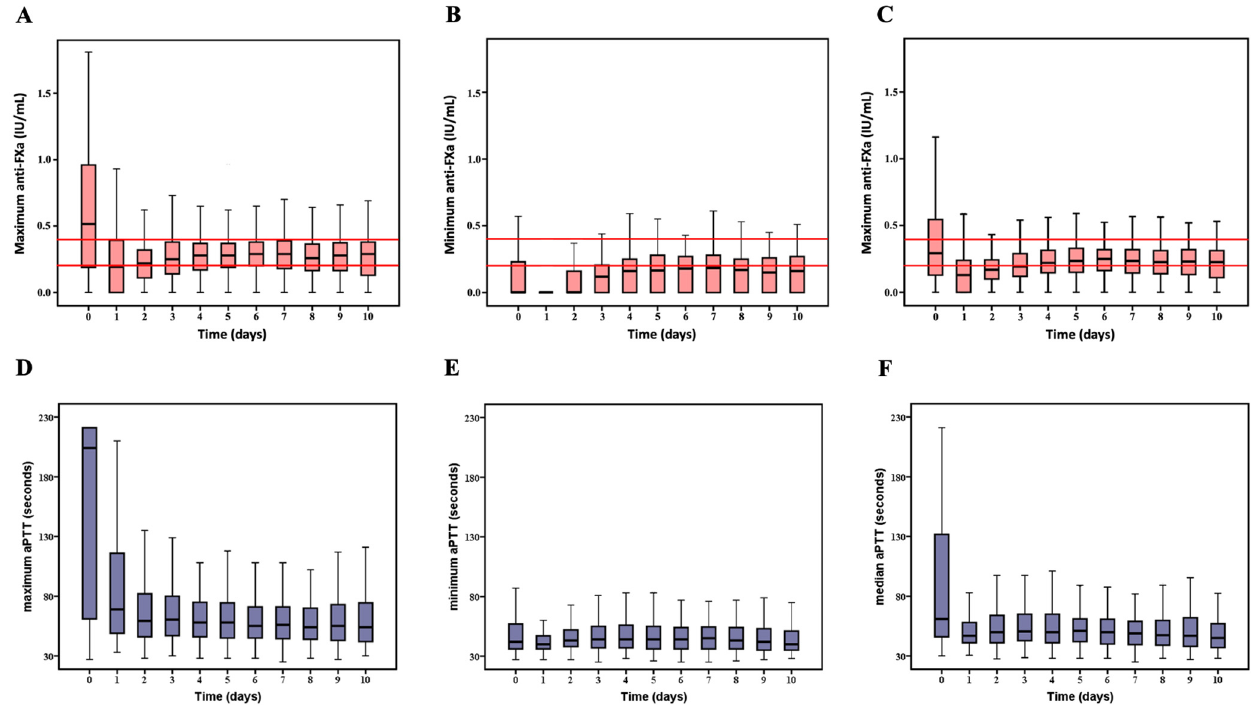
Figure 4. Time courses of daily maximum, minimum and mean values of anti-FXa and aPTT. The pink Tuckey diagrams showing the time course of the daily maximum ( A ) minimum ( B ) and mean ( C ) values of anti-FXa. The reference line for the lower and the upper limit of the anti-FXa used in our centre are coloured red. The bleu Tuckey diagrams showing maximum ( D ), minimum ( E ) and mean ( F ) values of aPTT.